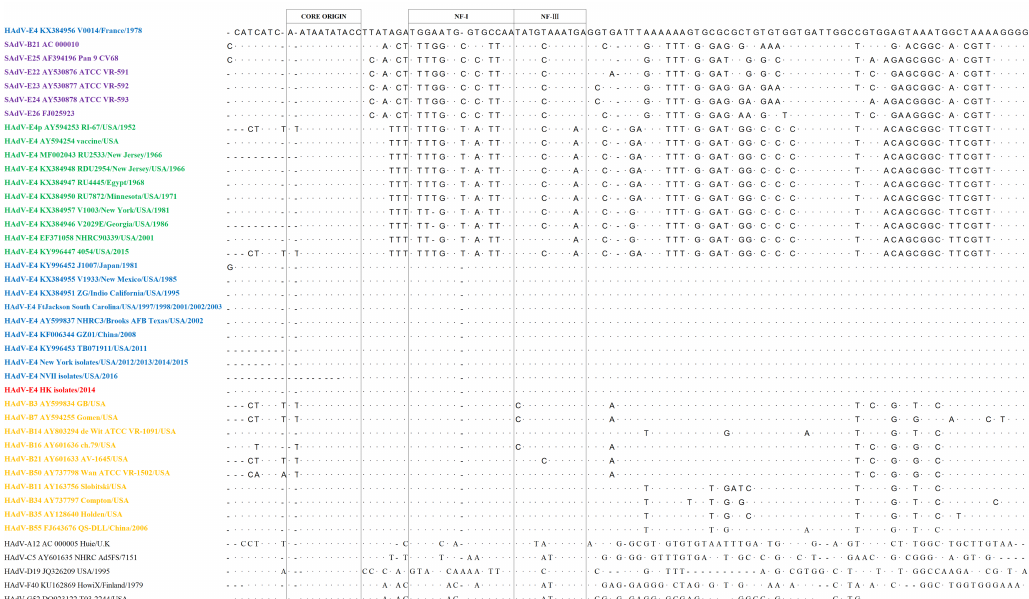
Figure 1. Human adenovirus Inverted Terminal Repeats (116–209 bases) embed replication protein- binding motifs within 88 bases: “Core origin”, NF-I (Nuclear Factor I), and NF-III. Host transcription factors NF-I and NF-III enable adenovirus replication in human cells. The first recorded host-adapted HAdV-E4 (Human adenovirus type 4) ITR (inverted terminal repeats) is arrayed along the top (V0014/France/1978), contrasted against differences in motifs from SAdVs (simian adenoviruses) (lavender) and prototype-like HAdV-E4 (green). Dots indicate conserved bases. Recent host-adapted HAdV-E4 isolates (blue), including five isolates from Ft. Jackson, spanning six years, and 10 recent Hong Kong isolates (red) contain these motifs and are nearly indistinguishable from motifs from HAdV respiratory pathogens (yellow). The majority of HAdVs possess these motifs (black), with the most divergent being